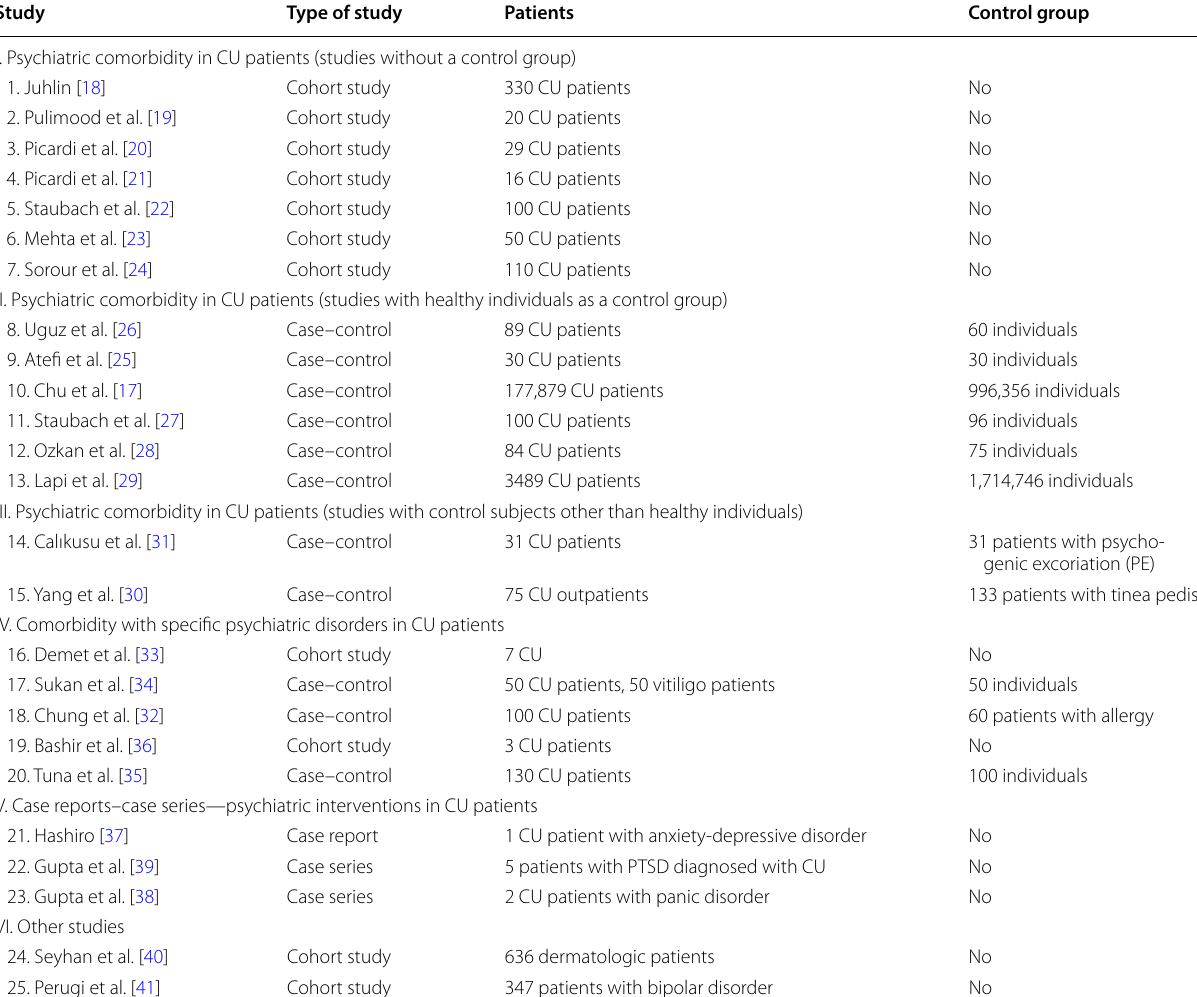
Table 1 Psychiatric comorbidity among chronic urticaria patients: all studies Study Type of study Patients Control group